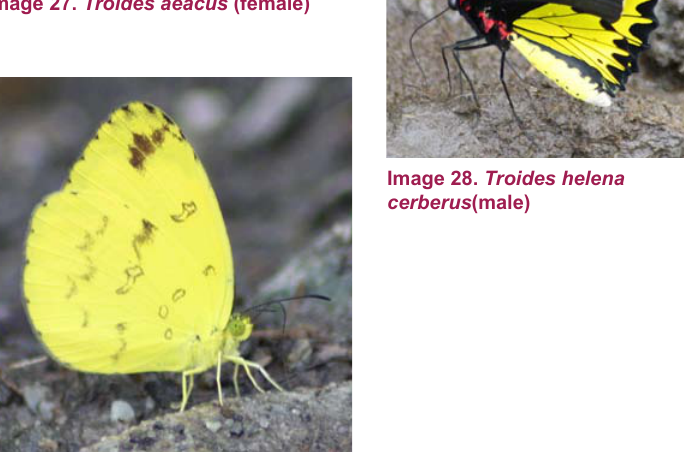
Image 30. Eurema andersoni andersoni